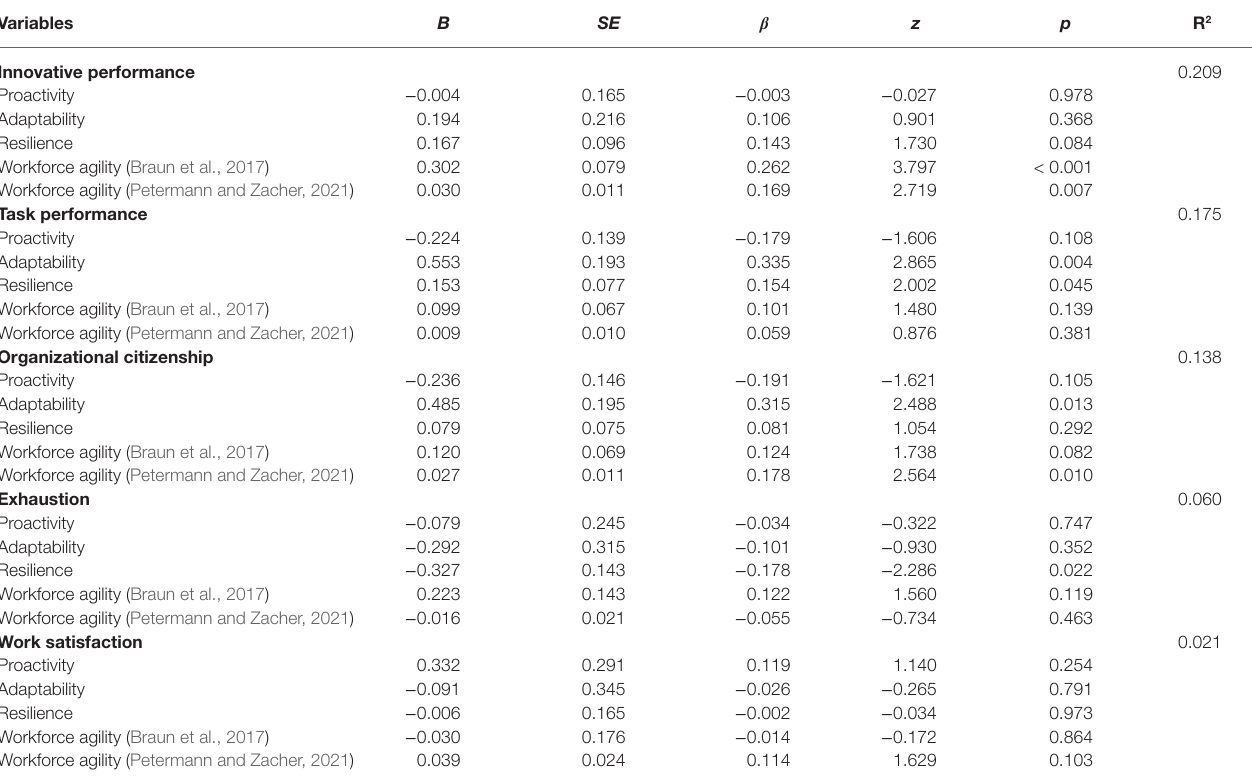
TABLE 8 | Results of regression